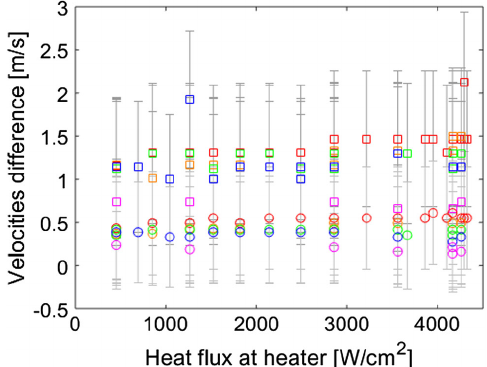
FIG. 13. Difference between the apparent second sound veloc- ity and the literature values versus heat flux at heater. Values are given for OST 1 (squares) and OST 2 (circles), and for five sets of temperature: 1.35 K (red), 1.41 K (orange), 1.7 K (green), 1.88 K (blue) and 2.1 K